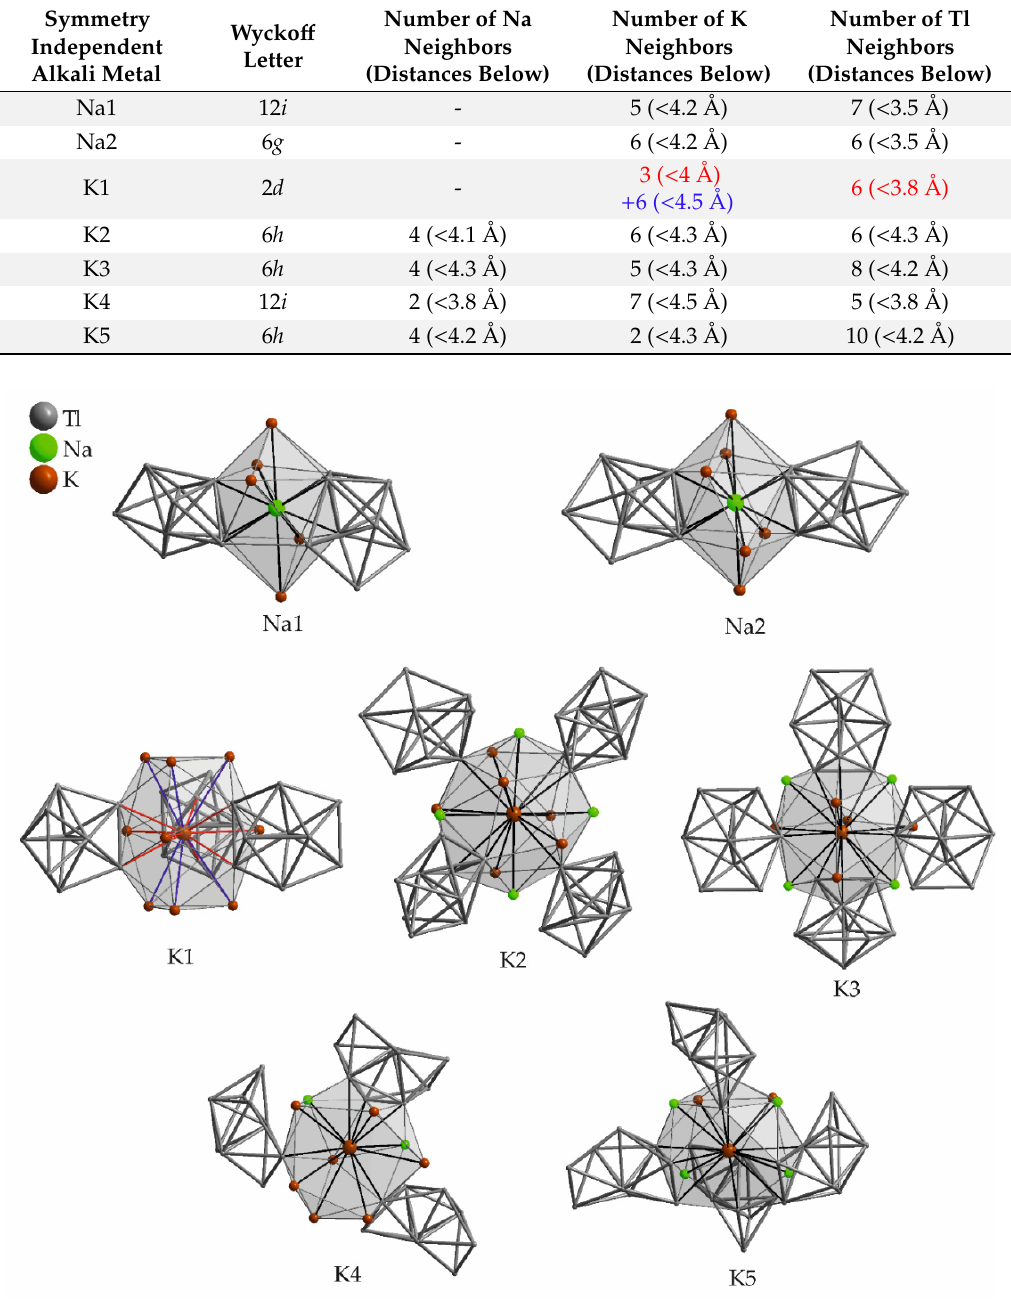
Figure 10. Atomic environment of the symmetry inequivalent sodium and potassium positions in Na 9 K 16 Tl 25.25 . The corresponding range of distances to the adjacent atoms as well as the Wyckoff letters are given in Table 12. Shorter contacts are colored red, longer distances are given in blue, the color coding is also used in the corresponding table (Table 12).